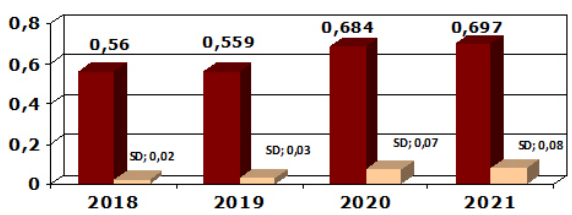
year = 22,4±3,69 (Table